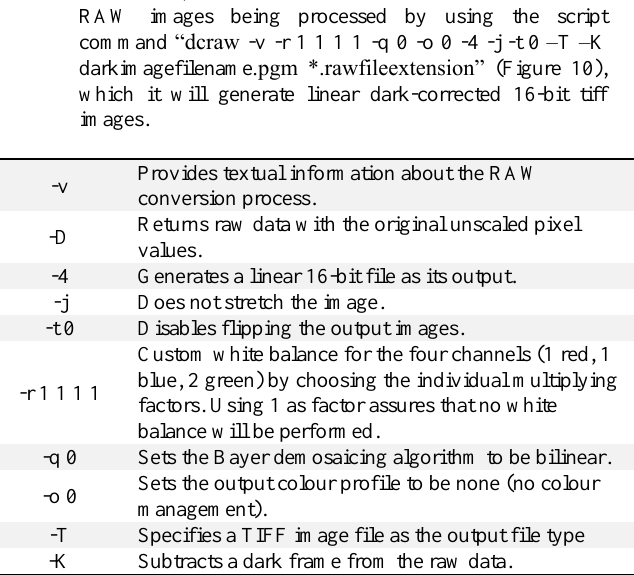
Figure 10: DCRaw command parameters explanation, according to Luijk (2007) & DCRaw